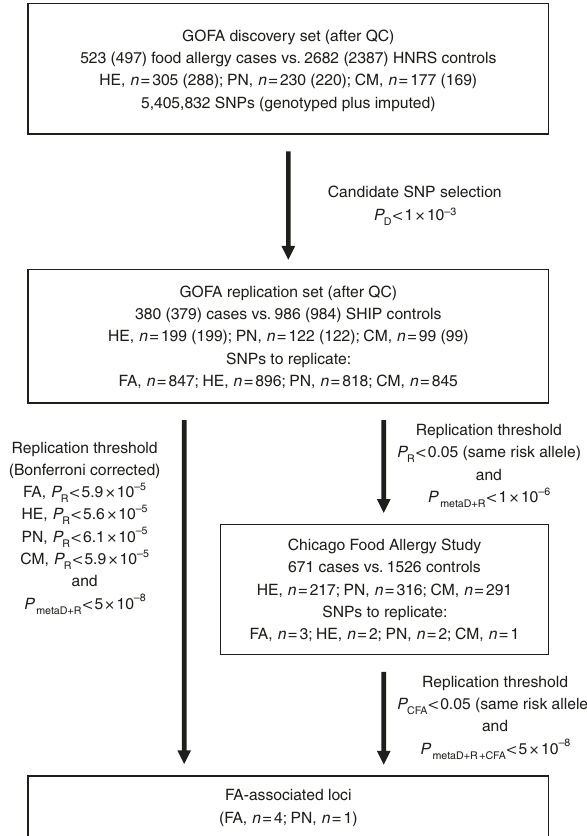
Fig. 1 Study design of the GWAS on food allergy. Work fl ow of the GWAS on food allergy is shown including the number of cases and controls, and the P value thresholds used for each study set and phenotype. GOFA German Genetics of Food Allergy Study, HNR Heinz Nixdorf Recall Study, SHIP Study of Health in Pomerania, CFA Chicago Food Allergy Study, QC quality control, FA any food allergy, HE hen ’ s egg allergy, PN peanut allergy, CM cow ’ s milk allergy, P D , P R , and P metaD+R , P value in the GOFA discovery set, in the GOFA replication set, and in the meta-analysis of both